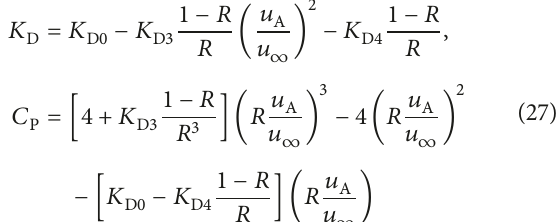
| 𝑅=1 , shown as a function of the duct size Pmax .